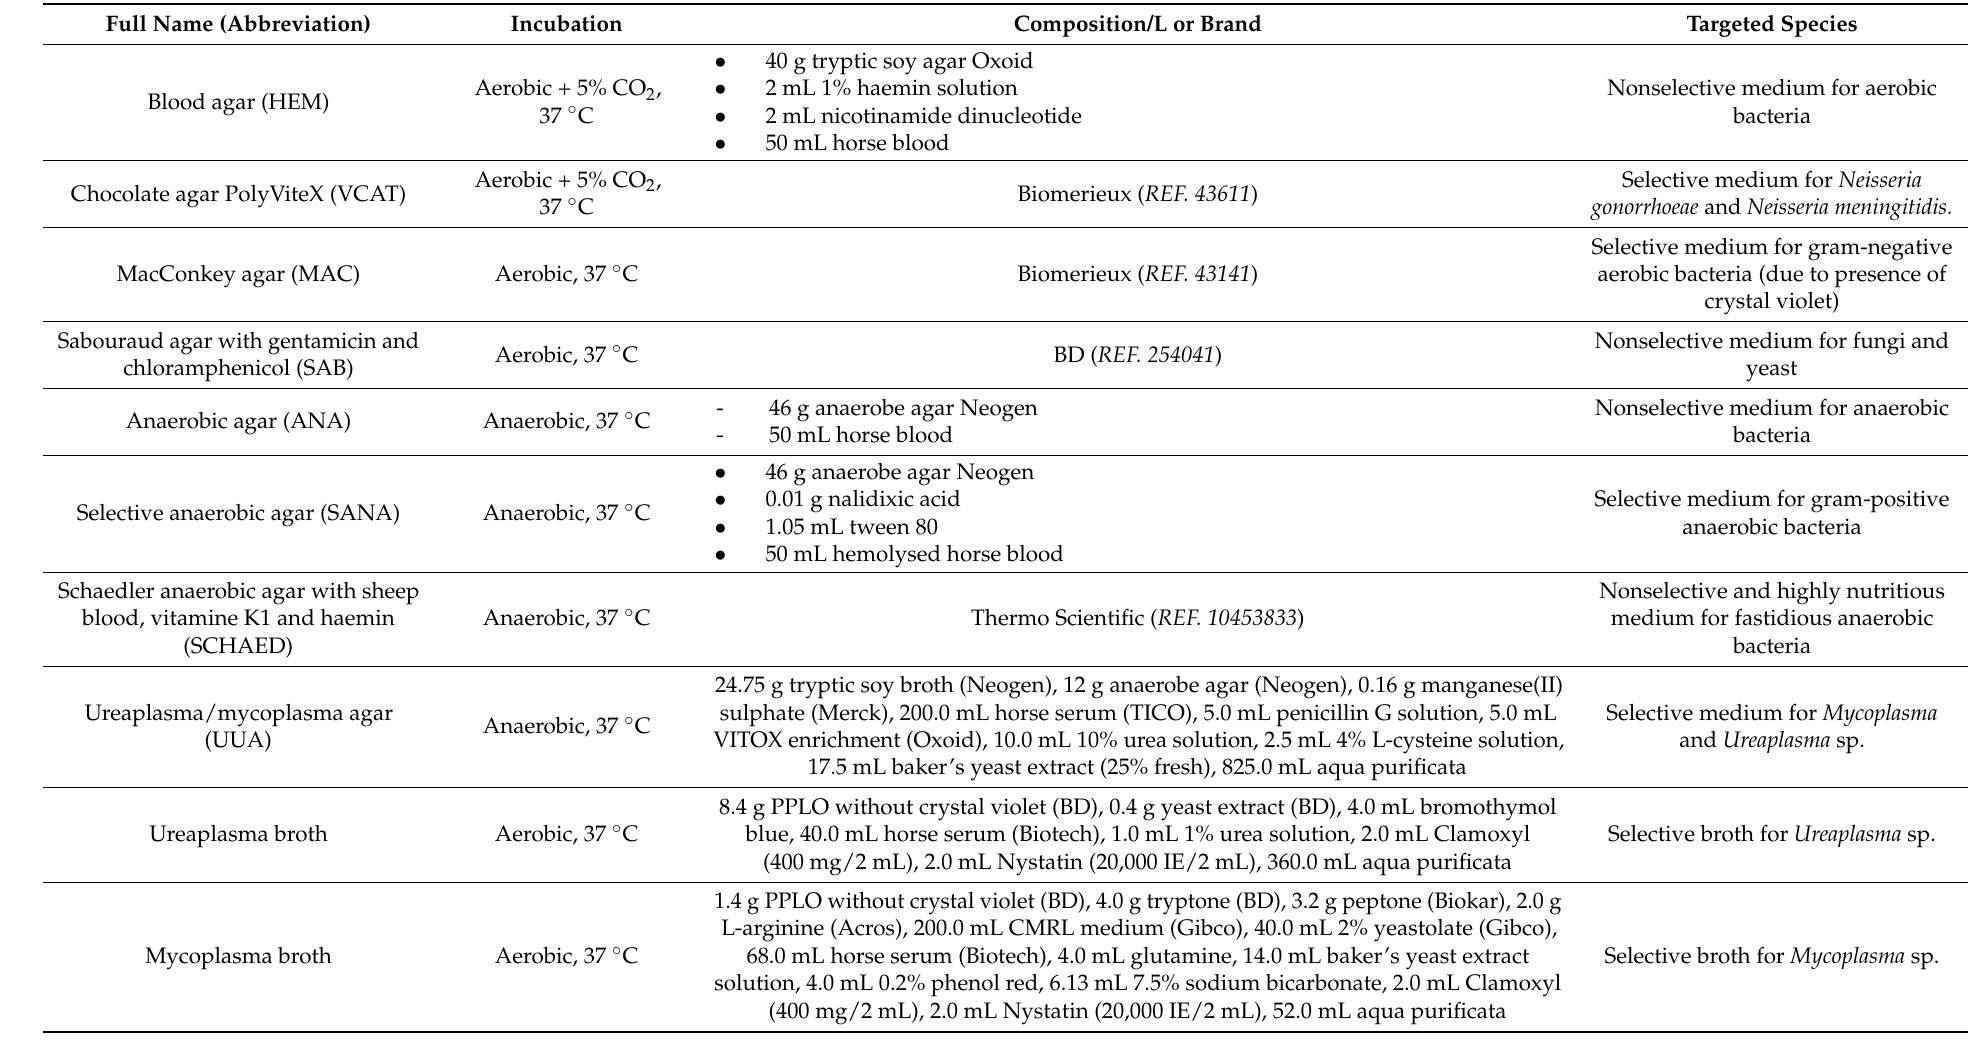
Table 4. Summary of all of the used culture media, incubation circumstances, composition and targeted